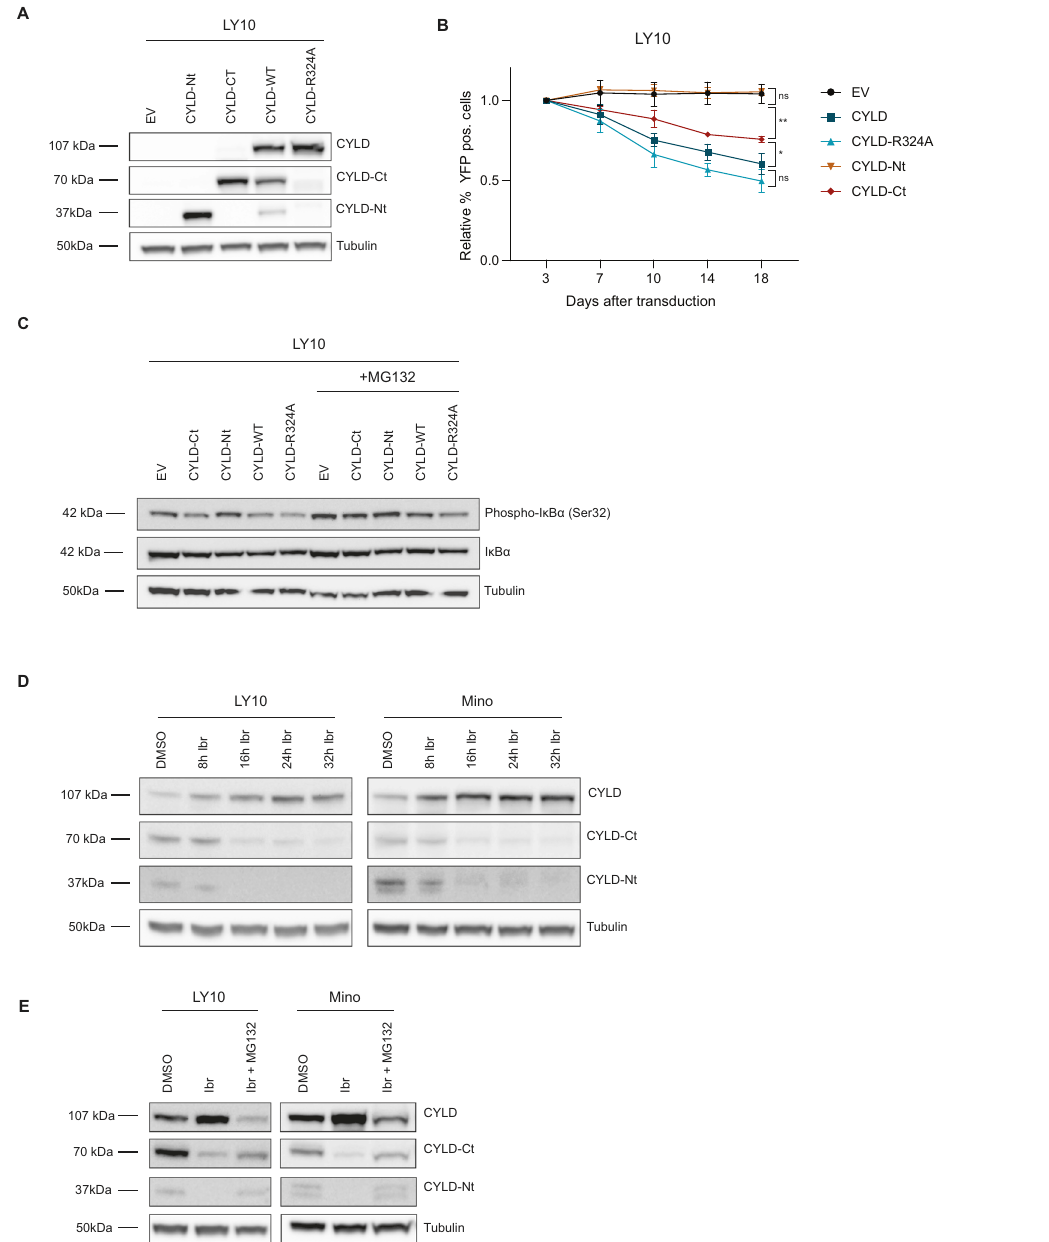
Fig. 5 MALT1-dependent proteolytic cleavage inhibits activity and promotes proteasomal degradation of CYLD. A Immunoblot analysis of CYLD variants in LY10. Cells were transduced with an empty vector (EV) or an expression vector for CYLD (N-terminal fragment, C-terminal fragment, WT or non-cleavable R324A mutant) and sorted for YFP expression. CYLD was detected using an antibody raised against a C ‐ terminal epitope which detects full-length CYLD and a C ‐ terminal fragment of CYLD (CYLD ‐ Ct), or an antibody against an N ‐ terminal epitope for detection of the N-terminal fragment (CYLD-Nt). β -tubulin was used as loading control. B Flow cytometric analysis of LY10 cells transduced with an empty vector (EV) or a bicistronic expression vector for CYLD (N-terminal fragment, C-terminal fragment, WT or non- cleavable R324A mutant) co-expressing YFP. The percentage of YFP positive cells was followed in time and plotted as the percentage of YFP + cells, normalized to the value at day 3 following retroviral transduction. The mean ± SD of four independent transductions is shown. P > 0.05; ns (non-signi fi cant); * P < 0.05; ** P < 0.01 using 1-way ANOVA with Tukey ’ s multiple comparisons test. C Immunoblot analysis of (phosphorylated) IkB α in LY10 transduced with an empty vector (EV) or an expression vector for CYLD (N-terminal fragment, C-terminal fragment, WT or non-cleavable R324A mutant) expressing vector. Three days after sorting cells were incubated with or without 5 µM proteasome inhibitor MG132 for 3 h before harvesting. β -tubulin was used as loading control. D Immunoblot analysis of CYLD cleavage in LY10 and Mino. Cells were incubated with 100 nM ibrutinib for the indicated time points. β -tubulin was used as loading control. E Immunoblot analysis of endogenous CYLD cleavage in LY10 and Mino. Cells were incubated with 100 nM ibrutinib for 24 h in the presence or absence of 10 uM MG132. To prevent apoptosis, cell lines were co-incubated with 10 µM Q-VD-OPh (QVD). β -tubulin was used as loading